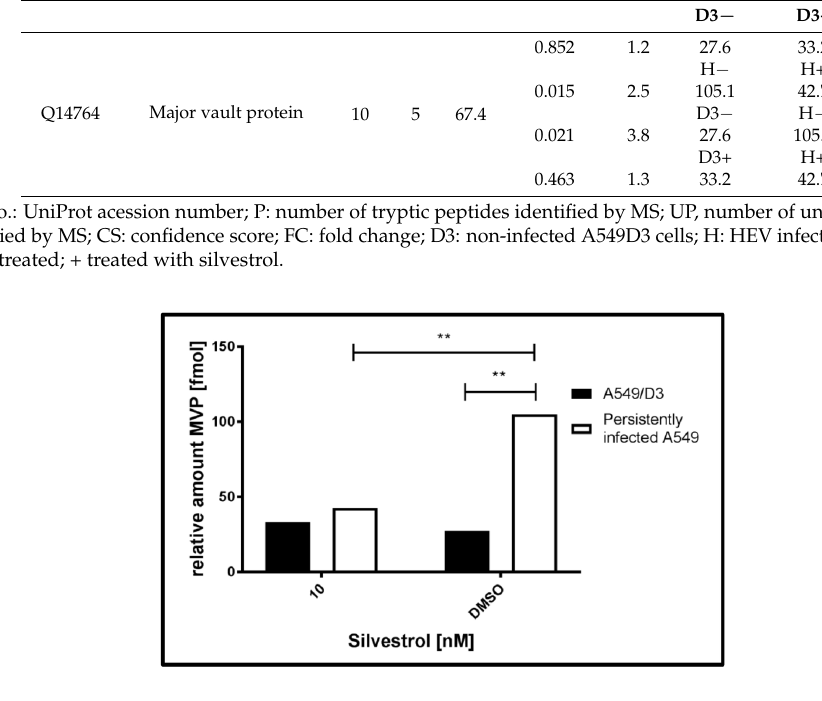
Table 1. Identification and quantification of MVP by UDMS E . Cytosolic protein levels of Major Vault Protein (MVP) (UniProt accession number, number of tryptic digests identified by MS, number of unique peptides identified by MS and confidence score listed in column 1 to 5) of 10 nM treated or non-treated A549/D3 or persistently HEV-infected A549 cells (column 8 and 9) with annotated p -values (column 6) and fold-change (column 7). Row 4: A545/D3 untreated vs. A549/D3 treated; Row 6: infected A549 untreated vs. infected A549 treated; Row 8: A549/D3 untreated vs. infected A549 untreated; Row 10 : A549/D3 treated vs. infected A549 treated. n = 3. Protein Identification Protein Expression Level Acc.No. Description